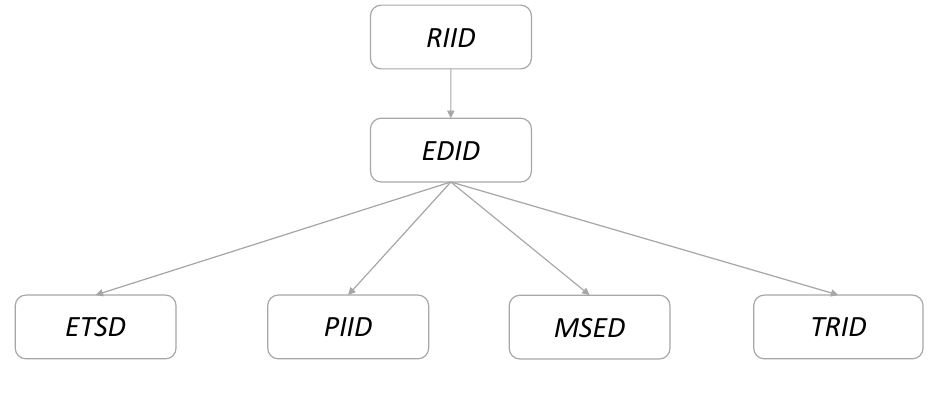
Figure 5. Serial relationship.